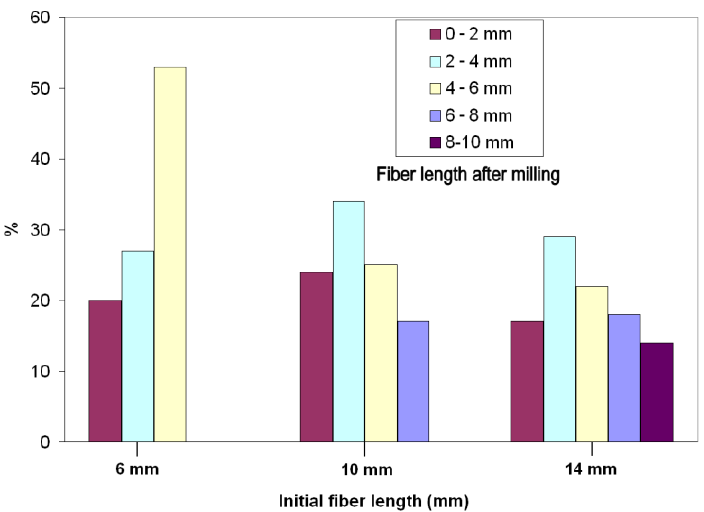
Figure 3. Different geometries of phormium fibers: ( a ) elongated, ( b ) quasi-circular, ( c ) keyhole, and ( d ) horseshoe.